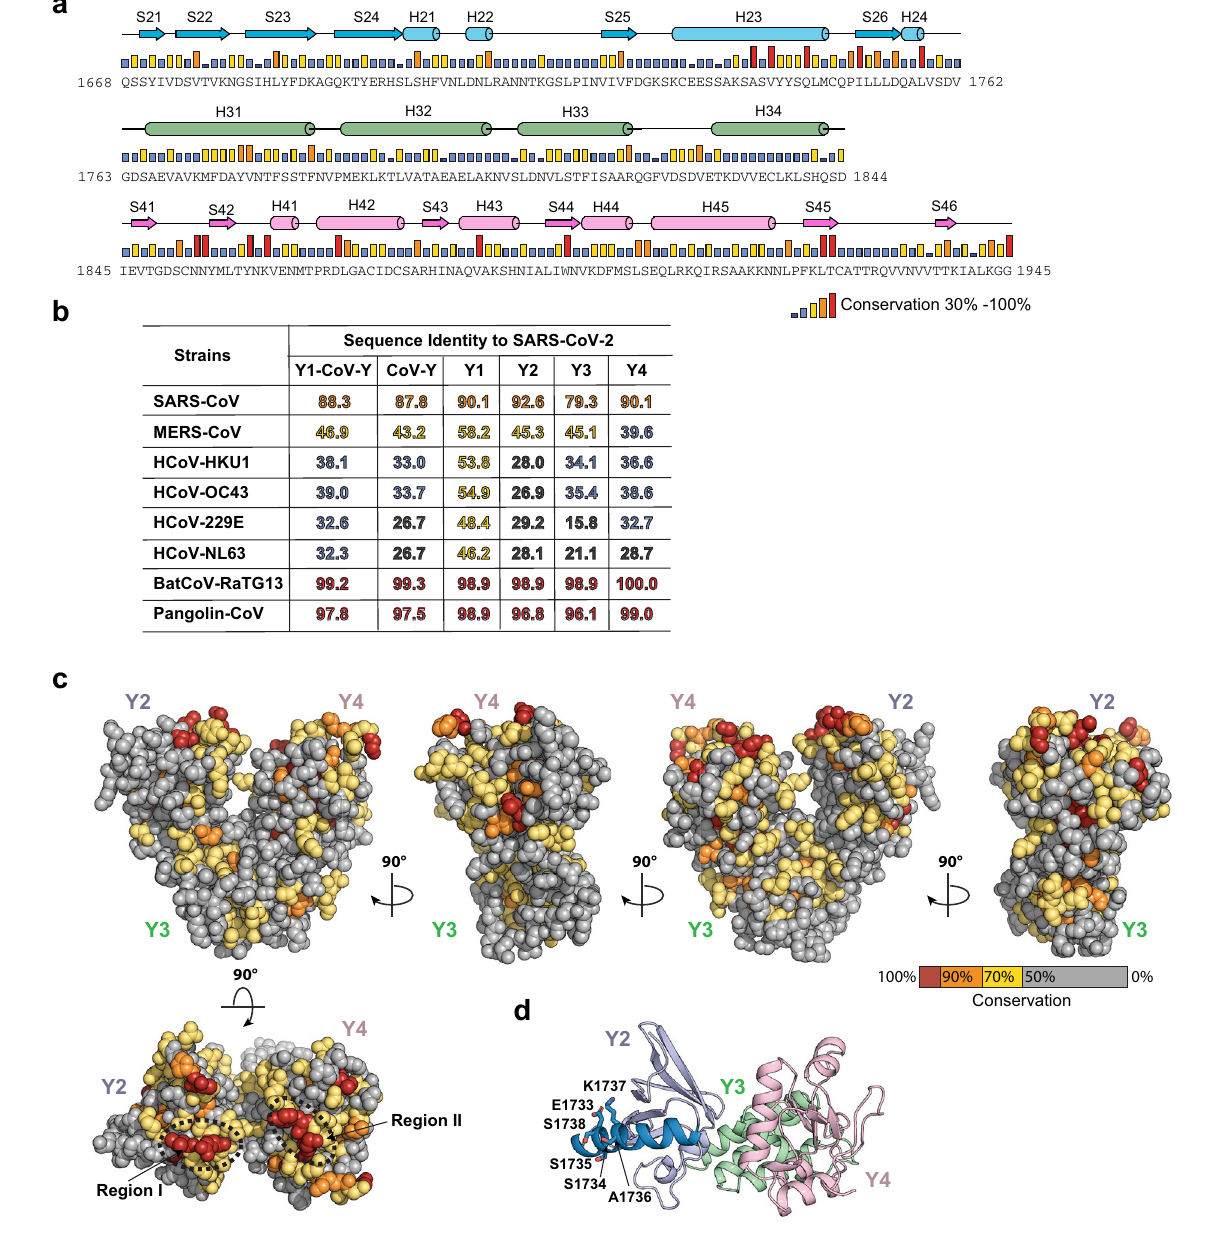
Figure 3. Sequence conservation among nsp3 CoV-Y homologs. ( a ) Sequence conservation of the nsp3 CoV-Y domain among seven human coronaviruses and two close relatives of SARS-CoV-2 (see “Methods” and Supplementary Fig. S5 for sequence information). Conservation is shown as a bar graph, with red bars indicating identity among nine CoV-Y homologs. Secondary-structure assignments of CoV-Y from the crystal structure are shown as cylinders (helices) and arrows (β strands). ( b ) Sequence identity of the Y1–CoV-Y, CoV-Y and four CoV-Y subdomains of the above eight coronavirus nsp3 sequences to those of SARS-CoV-2 nsp3. The ClustalW alignments were performed using DNASTAR Lasergene Suit 8. The identity numbers are shown in a color scale, with red indicating conservation above 95%. ( c ) Molecular surface of the CoV-Y domain structure colored according to homologous conservation. Dashed ellipse indicates the two highly conserved regions. ( d ) Close-up view of the H23 helix of Y2. The six residues with most variation in SARS-CoV-2 isolates are shown in stick